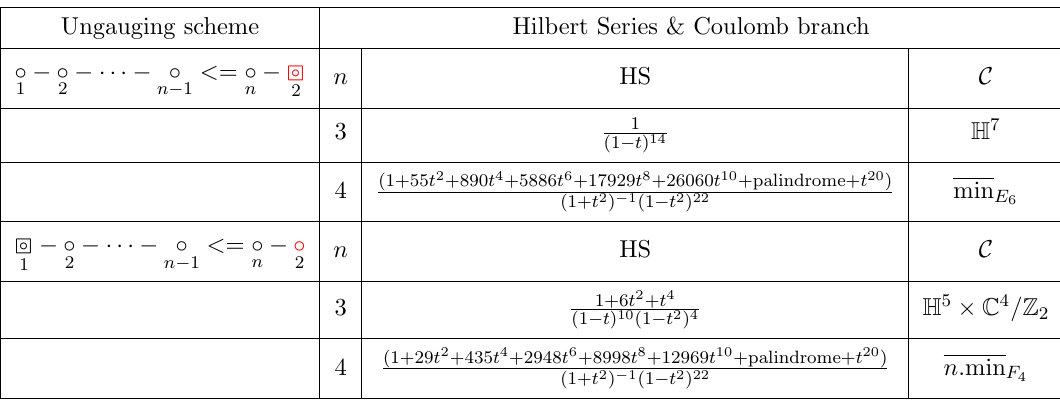
Table 8 . Di(cid:11)erent choices of ungauging schemes for the minimally unbalanced C n sequence. In summary of the last two sections, the Coulomb branch results for the a(cid:14)ne G and twisted a(cid:14)ne D (3)